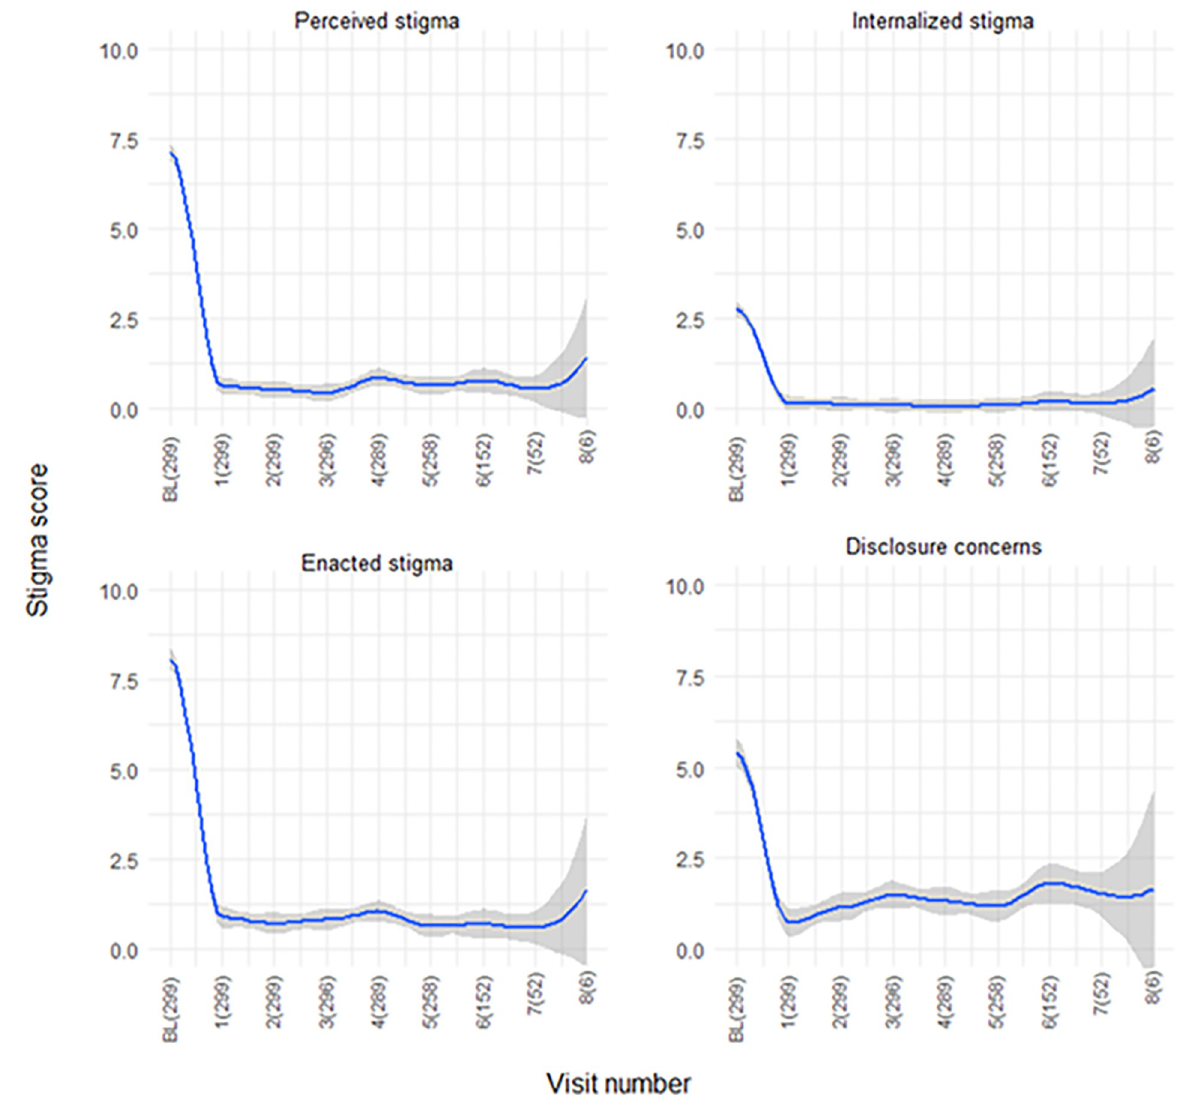
Fig 2. Stigma subscale scores at all study visits. Fig 2: Scatter plots of stigma sub-scores across visits with local regression lines using LOESS method and span = 0.2. X-axis labels are the study visit, followed by the number of participants sampled at that visit. Later study enrollees have not yet reached visits 6, 7 and 8. Gray bands represent 95% confidence intervals. Follow-up visits are not statistically different in the sub-scores: perceived-external stigma (F 7,1643 = 1.516, p = 0.152), internalized stigma (F 7, 1643 = 0.924, p = 0.487), and enacted stigma (F 7, 1643 = 1.14, p = 0.335). The disclosure concern score at visit 6, 1.81, was greater than the score at visit 1, 0.74 (F 7,1643 = 2.042, p = 0.0469).